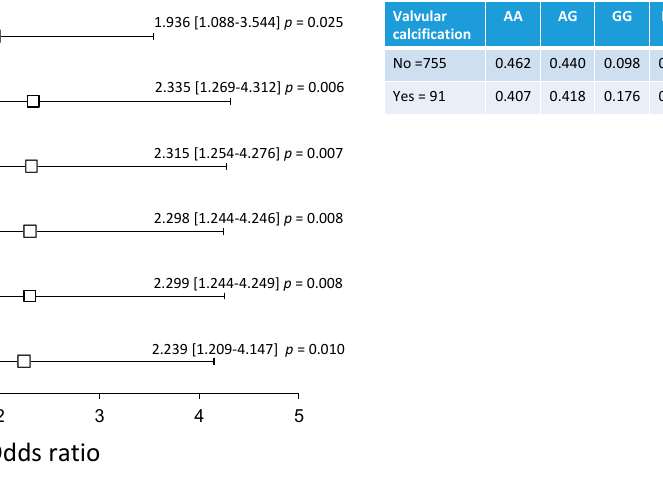
Figure 1. Association of the FOXA3 rs10410870 genotype with AVC. Model 1: unadjusted; Model 2: adjusted for age and sex; Model 3: Model 2 + adjusted for body mass index; Model 4: Model 3 + adjusted for LDL-cholesterol; Model 5: Model 4 + adjusted for type 2 diabetes mellitus; Model 6: Model 5 + current smoking.